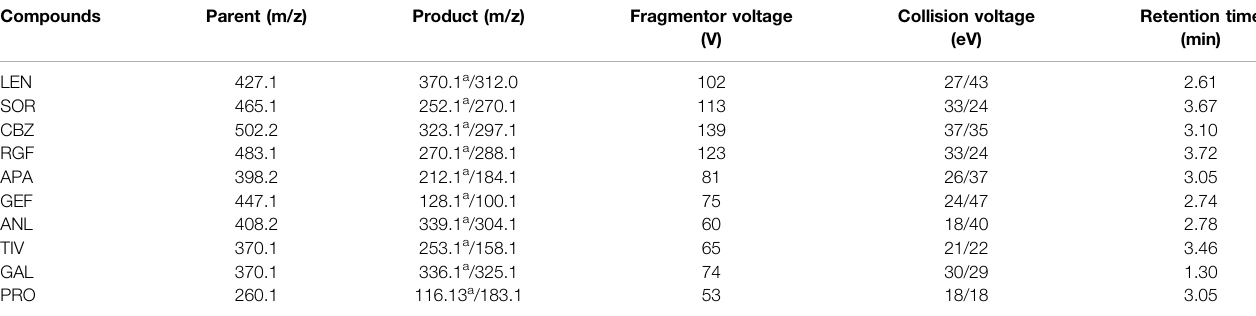
TABLE 1 | The MS condition of the 9 tyrosine kinase inhibitors and IS.